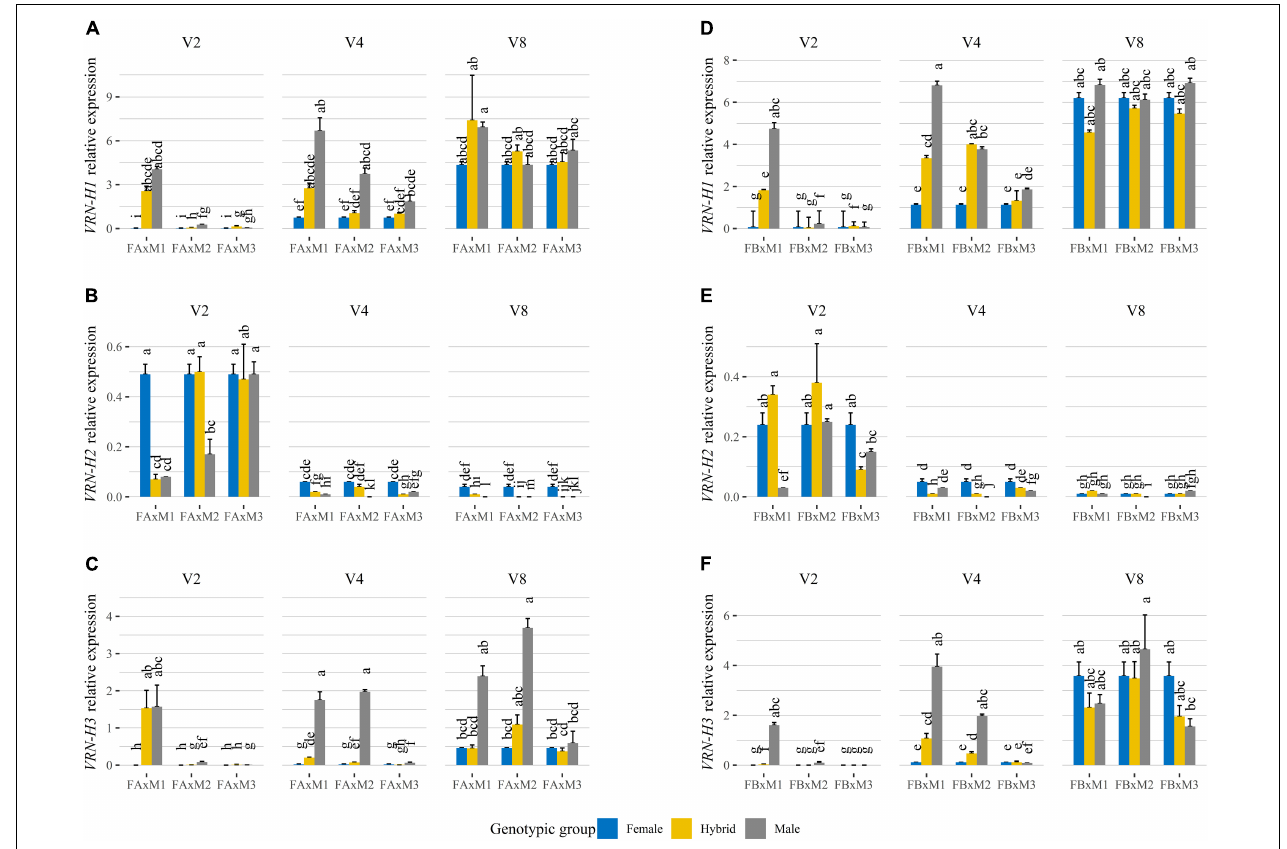
FIGURE 4 | Relative expression levels, at 35 days of growth in each treatment, of VRN-H1 (A,D) , VRN-H2 (B,E) , and VRN-H3 (C,F) assayed by qRT-PCR in triads of barley genotypes (Female, Hybrid, Male) grown under 16 h light, in response to different vernalization treatments (V2: 2 weeks of vernalization, V4: 4 weeks of vernalization, V8: 8 weeks of vernalization; 4–8 ◦ C, 8 h light). Plots (A–C) correspond to Female A crosses (Batch A). Plots (D–F) correspond to Female B crosses (Batch B). Each plot is divided into three facets, each of them containing gene expression assayed for one vernalization treatment, and the three triads of genotypes composed of one female parent in blue, the male parent in gray, and the hybrid in yellow. The triads are represented as abbreviations of the crosses between the parents, e.g., FA × M1: Female A × Male 1. The results shown are normalized to the level of the housekeeping gene Actin for each genotype and treatment. Mean of 3 biological replicates. Error bars represent the SEM. For each gene and batch, bars with a different letter are significantly different at P < 0.05, according to ANOVA that included genotypes and all